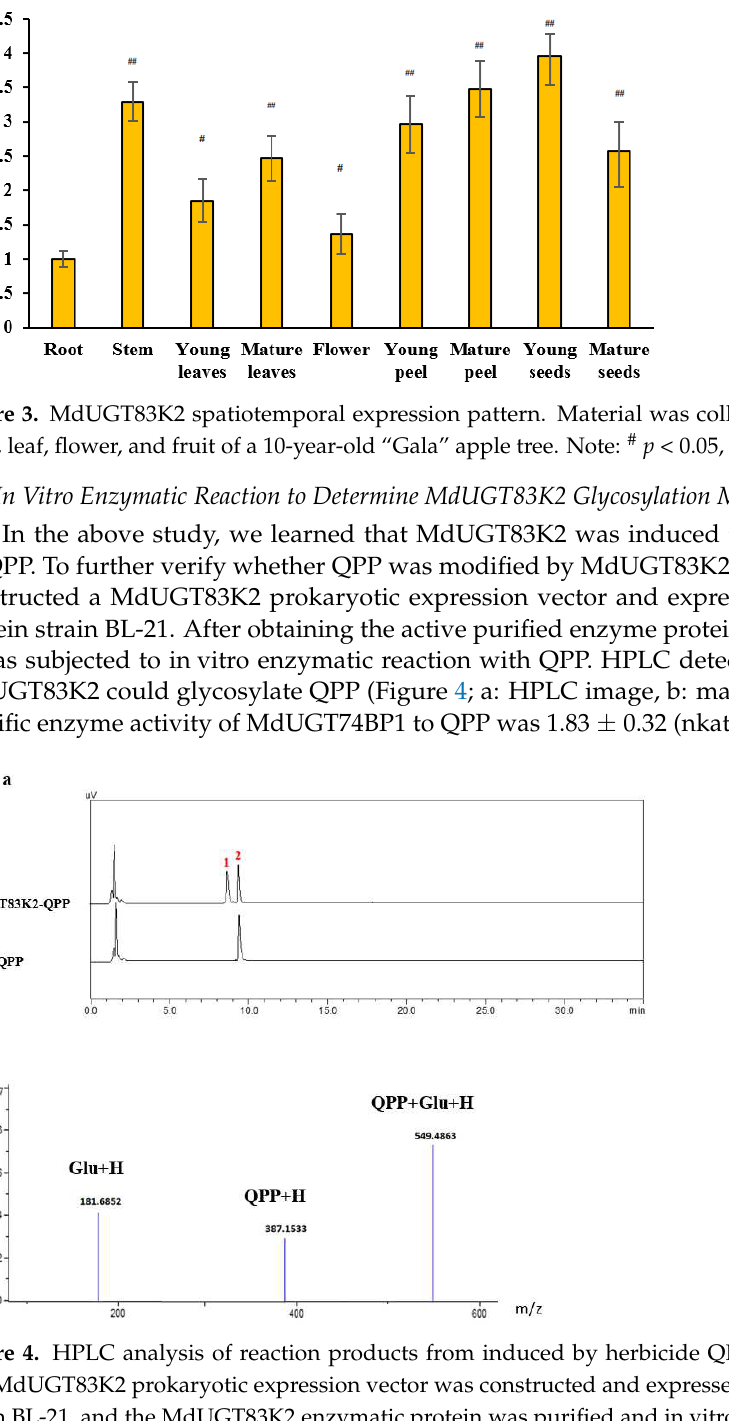
Figure 2. Expression of apple glycosyltransferase Group I family related genes induced by herbicide QPP. For the treatment of wild-type “Gala” seedlings (normal culture for 3 weeks), QPP synthesized